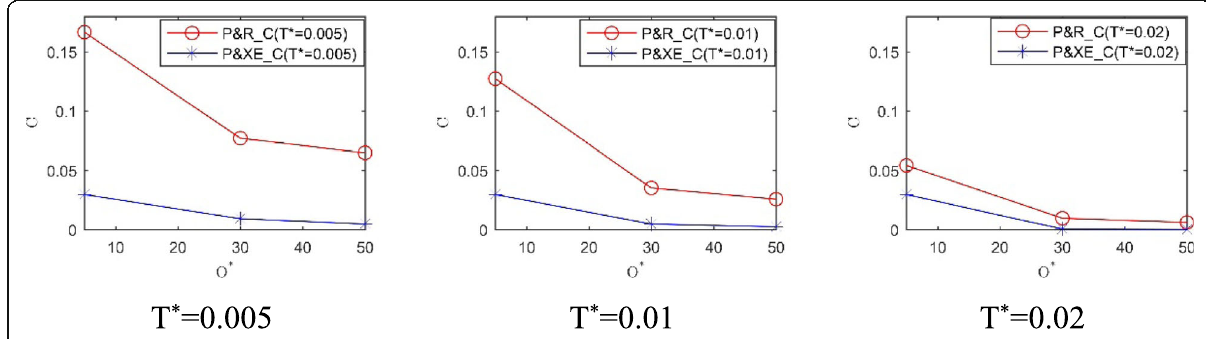
Fig. 9 Data survivability comparison under the same T* and O* constraints for n = 50 and 10 ≤ m ≤